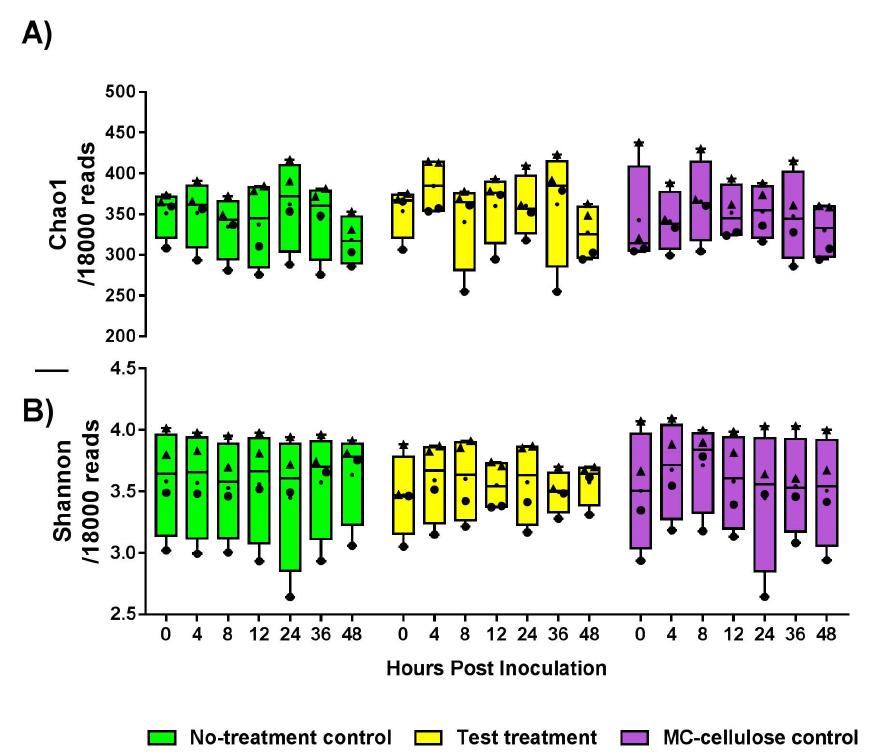
Figure 2. Chao1 estimates ( A ) and Shannon indices ( B ) of the identified microbiota from bioreactors with a no-treatment control, test treatment and microcrystalline cellulose control at di ff erent times post-treatment ( n = four biological replicates each; triangles are for donor 1 samples and circles for donor 2 samples). Results were calculated from rarefied 18,000 reads per sample. Middle lines represent mean. Data were analyzed using the Kruskal-Wallis test and Two-stage Benjamini, Krieger, and Yekutieli FDR procedure ( p >